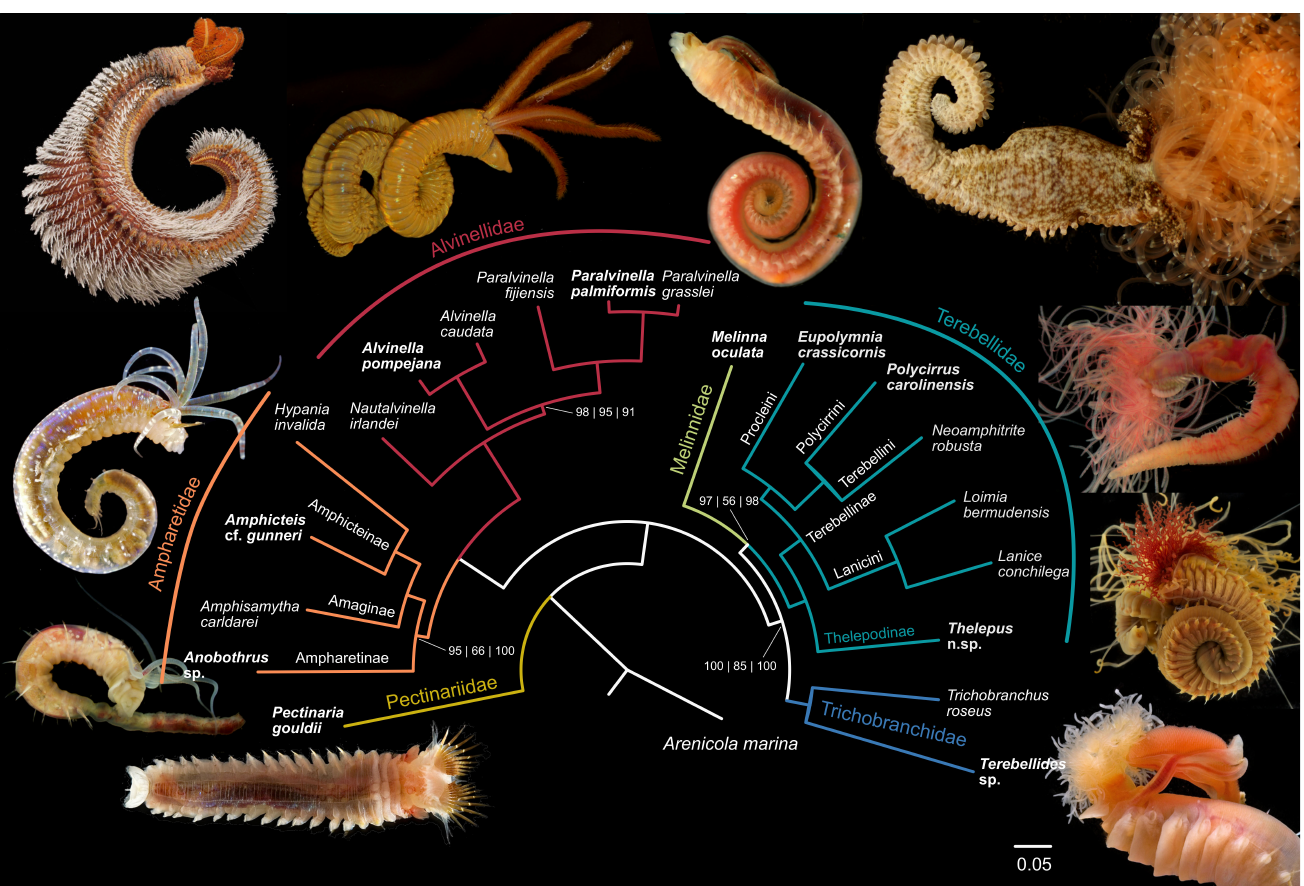
Figure 1. Relationships of the main groups of Terebelliformia based on transcriptomic data. The topology and branch lengths are from maximum likelihood inference on the supermatrix with 80% taxon occupancy ( ≥ 17 taxa, 1513 genes, 483,075 aa). The same topology was also found with 90% taxon occupancy, with all 12,674 gene trees summarized with ASTRAL, and when using subsets of the gene trees to reduce heterogeneity. Only nodes having less than full support in at least one of the analyses were annotated with support values, all others had full confidence across analyses. Support values are: bootstrap 80% matrix | bootstrap 90% matrix | ASTRAL local posterior probabilities. Photos correspond to the closest terminal in